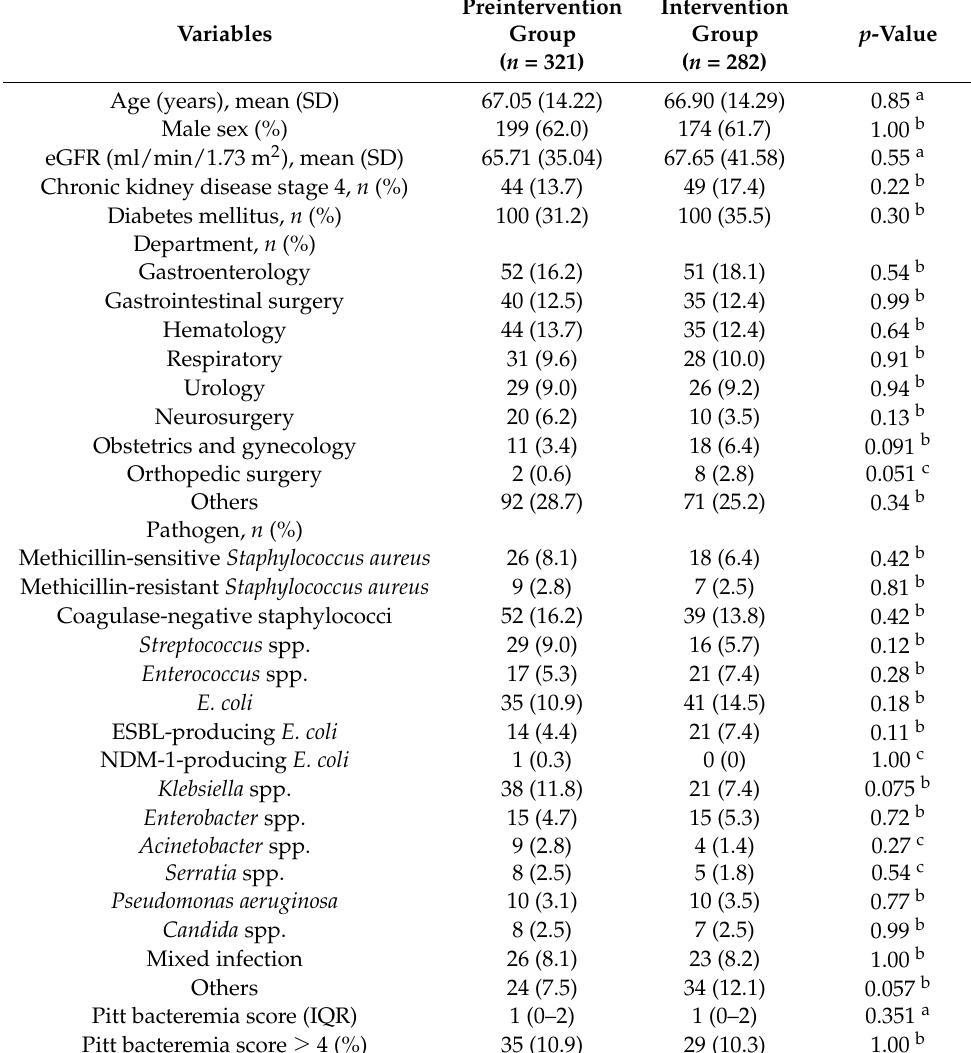
Table 1. Patient